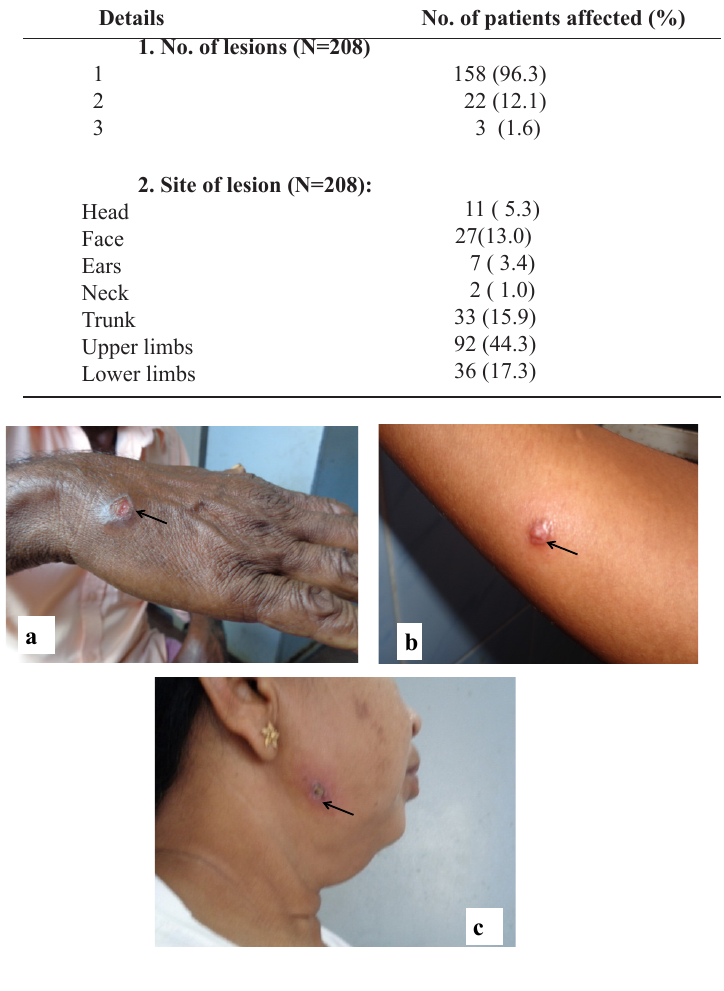
Figure 3: CL lesions a: on hand b: on arm c: on face of patients in current study